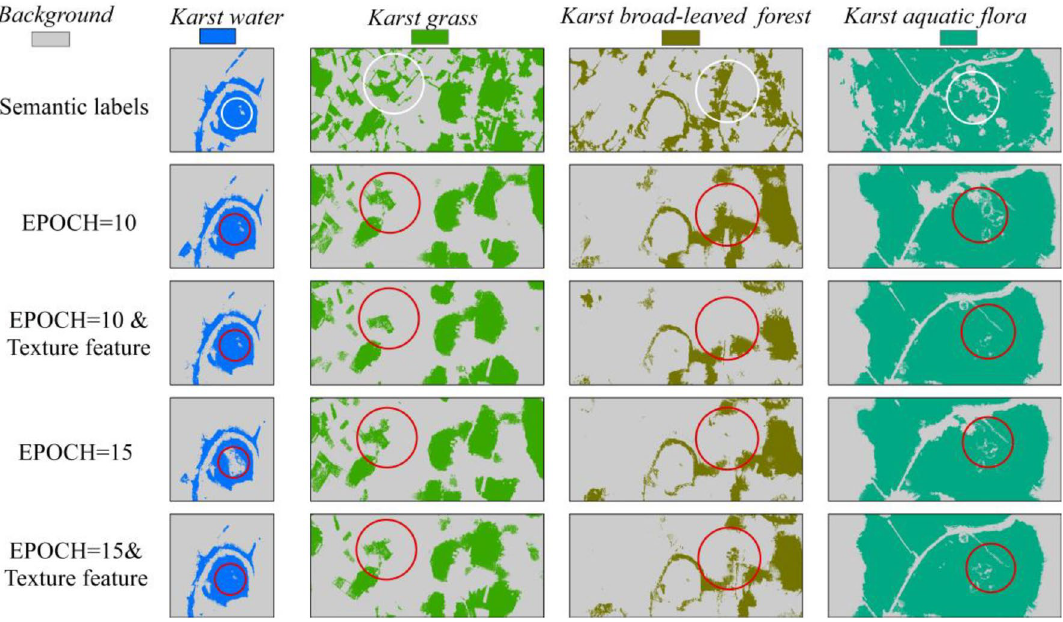
Figure 8. Single-class SegNet-based classifications for all karst wetland types with textural features. ArcGIS 10.6 software (http:// www. esri. com/ softw are/ arcgis) was used to process and map the data by first author (T. D.). The semantic labeling dataset was collected and created by T. D. and B.